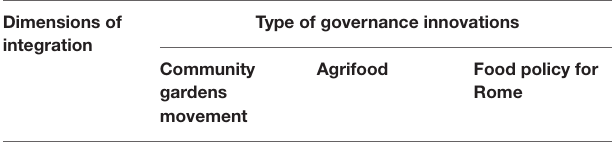
TABLE 2 | Analytical framework (source: